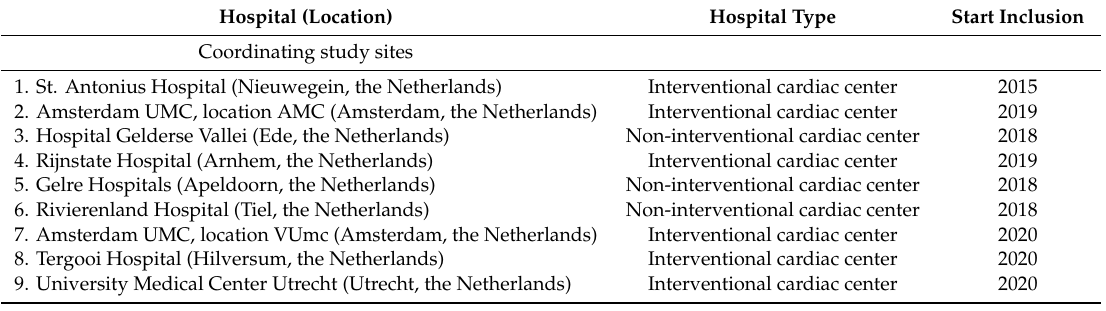
Table 1. Overview of participating secondary and tertiary cardiac centers in Future Optimal Research and Care Evaluation in patients with Acute Coronary Syndrome (FORCE-ACS) registry.